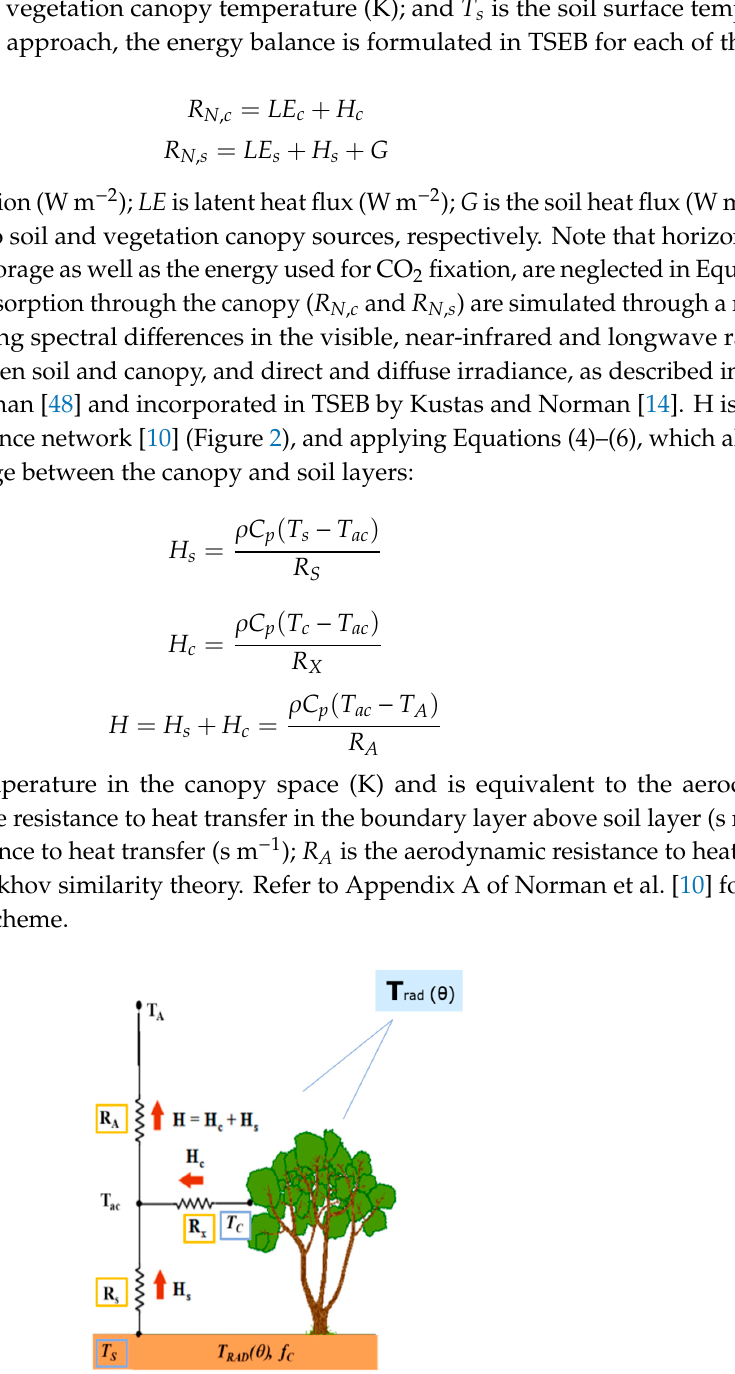
Figure 2. TSEB Sensible Heat model scheme (adapted from Kustas and Anderson [9]) .